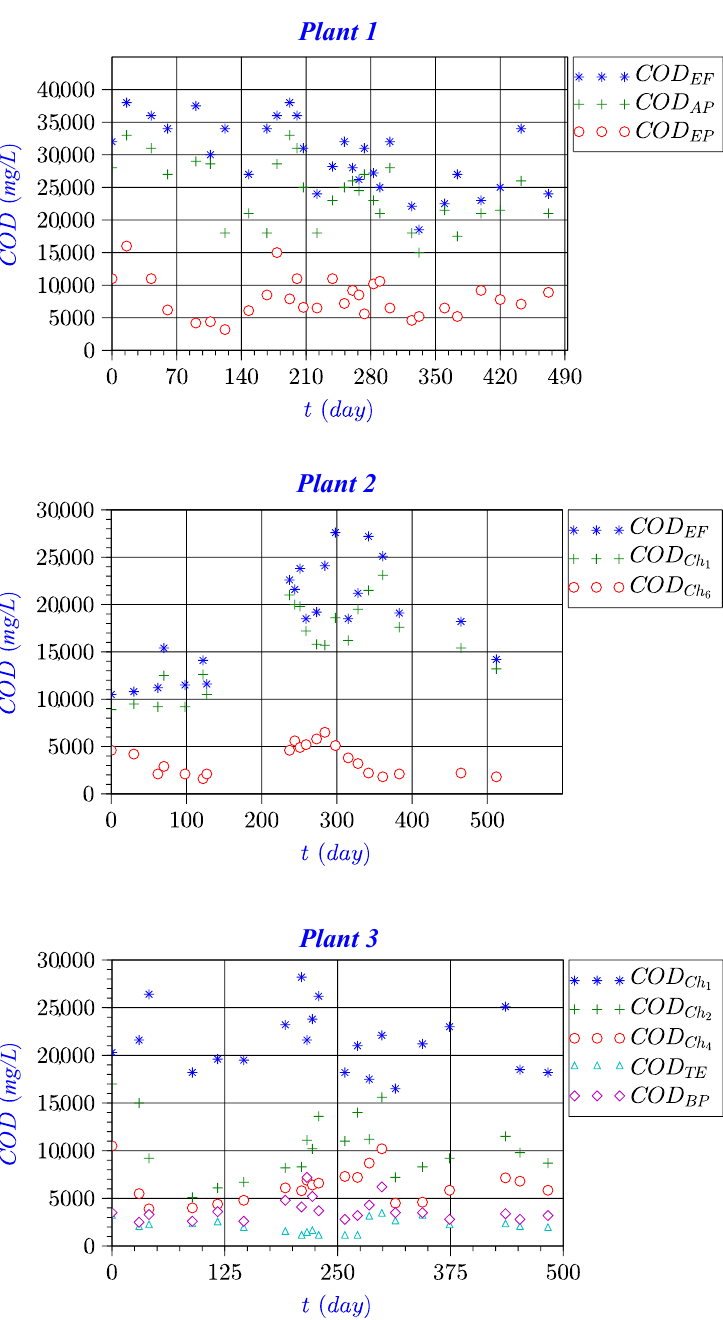
Figure 11. COD results for plants 1, 2, and